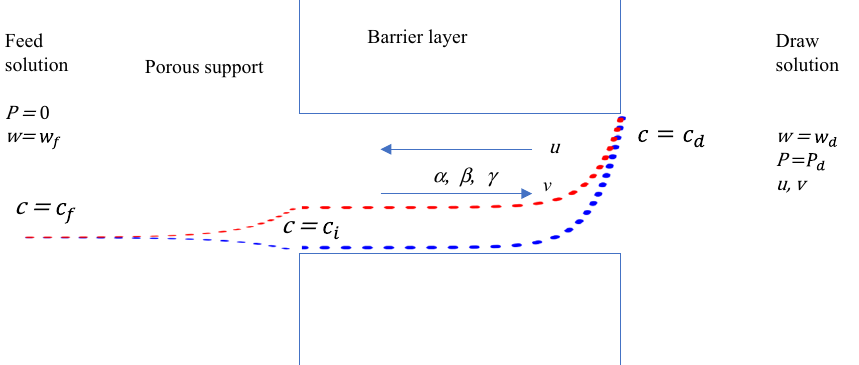
Figure 1. Solute concentration profiles in the breakthrough mode following from SKK with constant coefficients (blue) and MSKK (red): c —solute concentration, c f —feed concentration, c d —draw concentration,